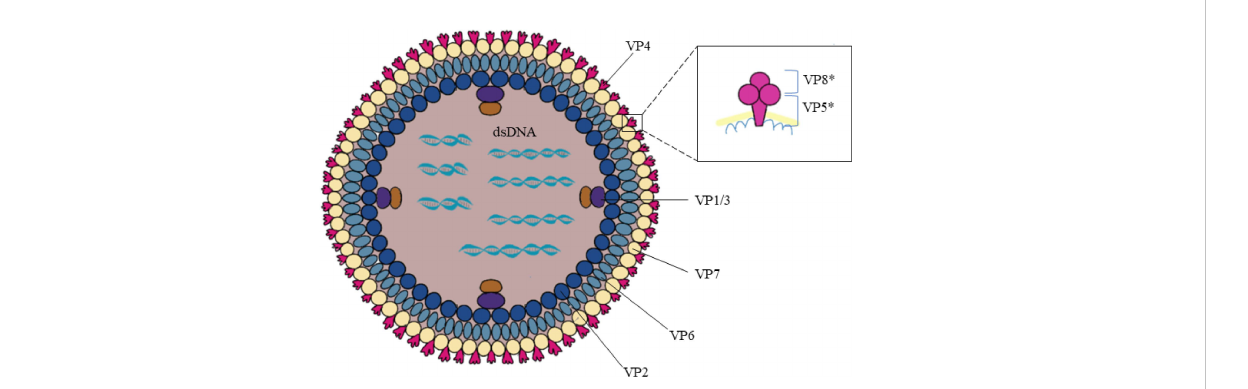
FIGURE 2 Rotavirus structure. Rotavirus consists of three concentric coat layers surrounded by 11 segmented double-stranded RNA fragments with a genome length of 18,500 bp which encodes 6 structural proteins (VP1-4, VP6-7) and 5-6 non-structural proteins (NSP1-5/6). The capsid structure consists of an inner capsid layer (VP2), a middle capsid layer (VP6), and an outer capsid layer (capsid glycoprotein VP7 and hemagglutinin spike protein VP4). VP4 is cleaved into VP5* and VP8* by the action of trypsin which enhances rotavirus infectivity. The bottom of the VP5* protein is half-buried inside the VP6